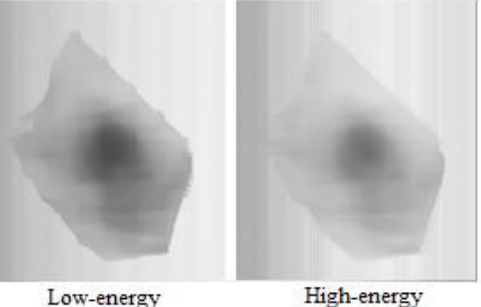
Figure 8. Effect of improved adaptive Kalman-median filter (local enlarged image of Figure 1 after image processing).